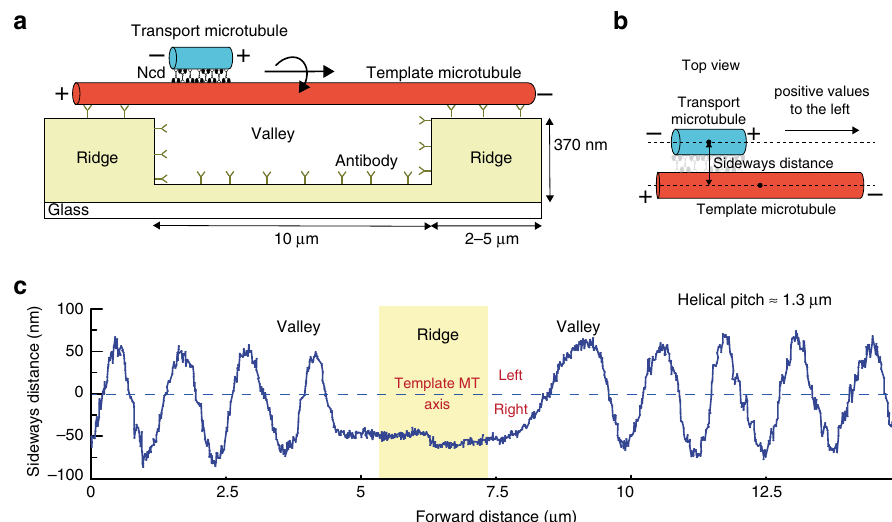
Fig. 1 3D sliding of transport microtubules driven by Ncd on suspended template microtubules. a Schematic representation of a suspended, rhodamine- labeled, template microtubule immobilized on optically transparent polymer ridges by anti-rhodamine antibodies. Atto647n-labeled transport microtubules are capable of freely accessing the 3D lattice of the template microtubule between the ridges (in the region referred to as valley), as they slide along them driven by GFP-labeled Ncd motors. b The perpendicular distance of the center point of the transport microtubule from the tracked center line of the template microtubule provides the sideways distance. Positive values are arbitrarily assigned to positions on the left. c Sideways distance for an example antiparallel transport microtubule as it slides along a template microtubule over two valley regions (see also Supplementary Movie 1). In both valley regions, the 1.8 μ m long transport microtubule exhibited a helical motion around the suspended template microtubule, with a helical pitch of 1.3 ± 0.1 μ m ( N = 7 rotations, mean ± SD). At the ridge, where the template microtubule is surface-immobilized, the transport microtubule remained on the right-hand side of the template microtubule, indicating that the direction of helical motion is